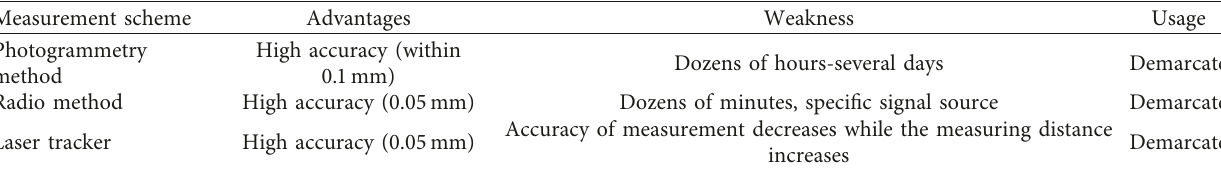
Table 1: Summary of the main measurement techniques of the antenna subreflector.